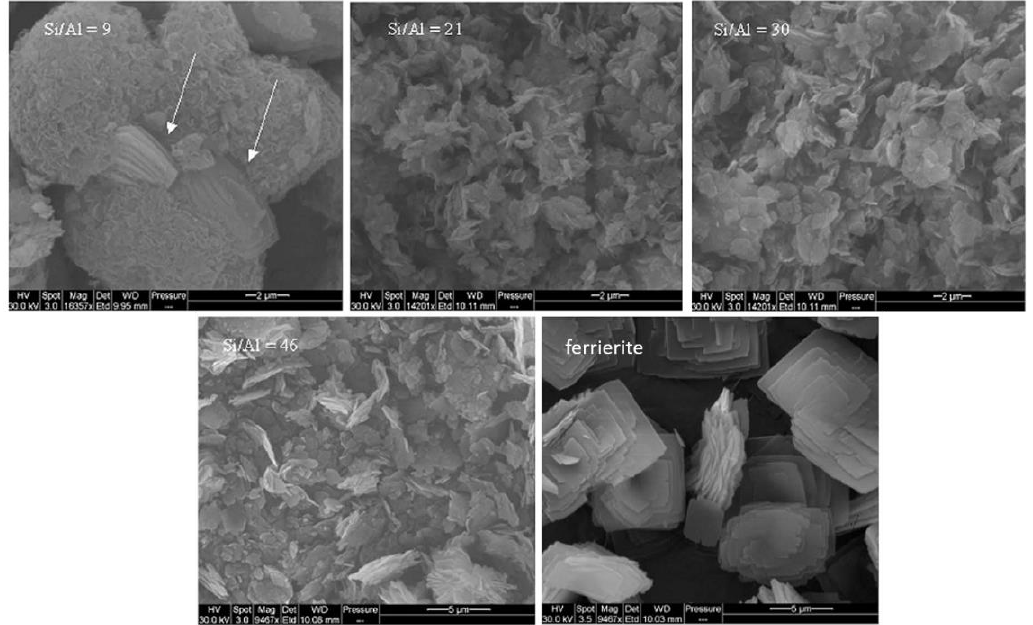
Figure 2. Morphologies of MCM-22 with different Si/Al molar ratios = 9, 21, 30, 46. The last image corresponds to pure ferrierite formed under static conditions. Adapted from Reference [19].